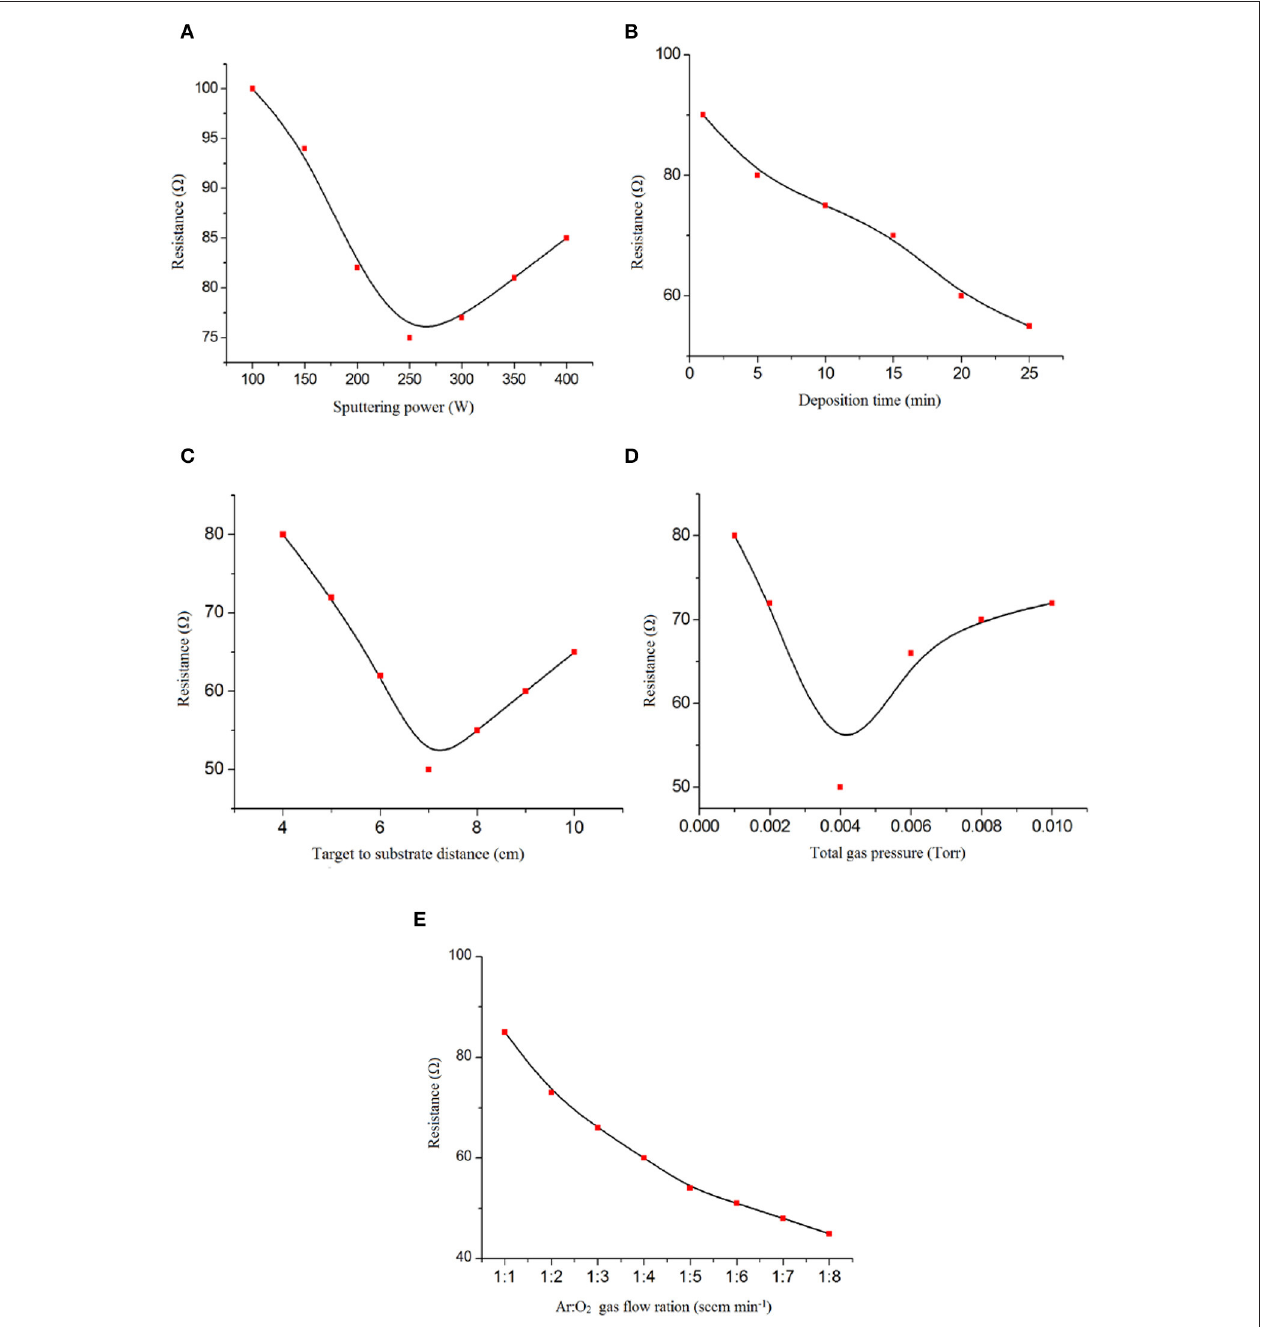
FIGURE 2 | Effect of (A) DC magnetron sputtering power, (B) deposition time, (C) target-to-substrate distance, (D) total gas pressure, and (E) Ar: O 2 gas ratio on nano-ZnO/polyvinyl alcohol (PVA)/fluorinated tin oxide (FTO)